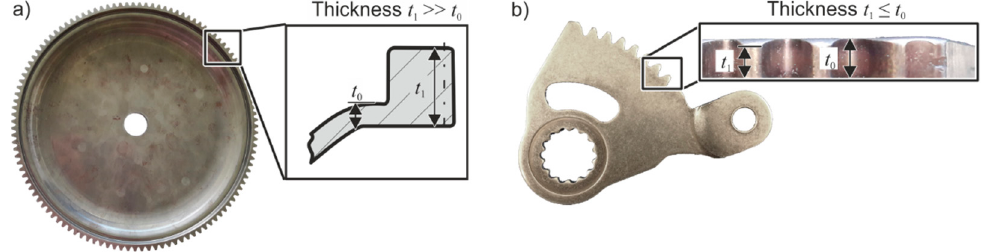
Figure 1. Conventionally manufactured functional components: ( a ) starter gear (Winkelmann) and ( b ) seat-adjuster (Faurecia).